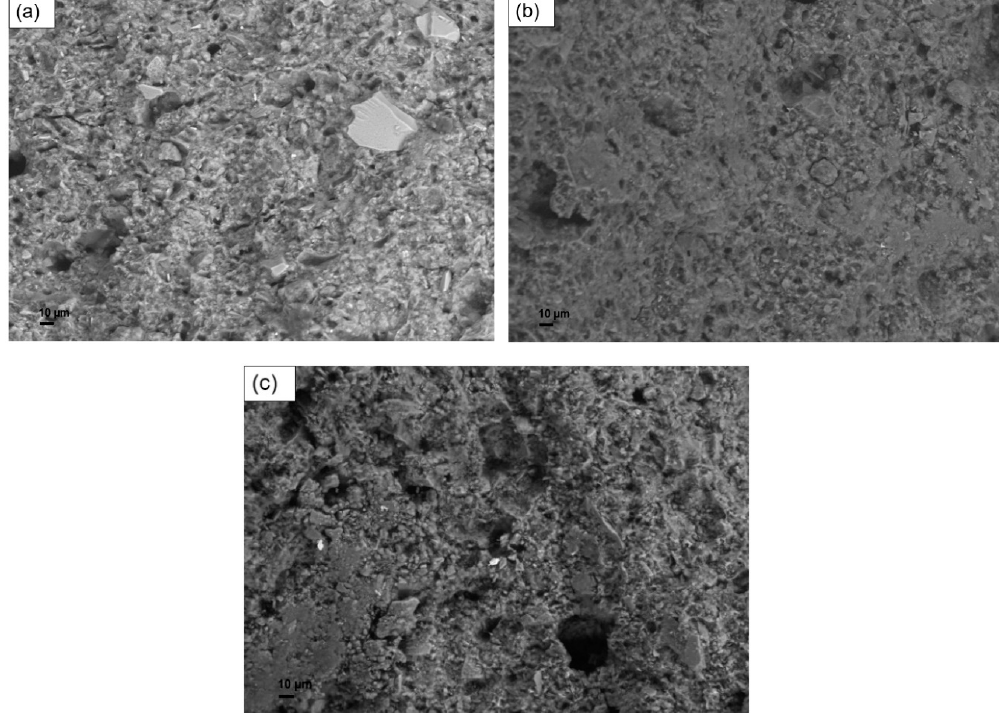
Figure 5. SEM micrographs of samples containing biomass: ( a ) G-S5; ( b ) G-T5; ( c ) G-L5.